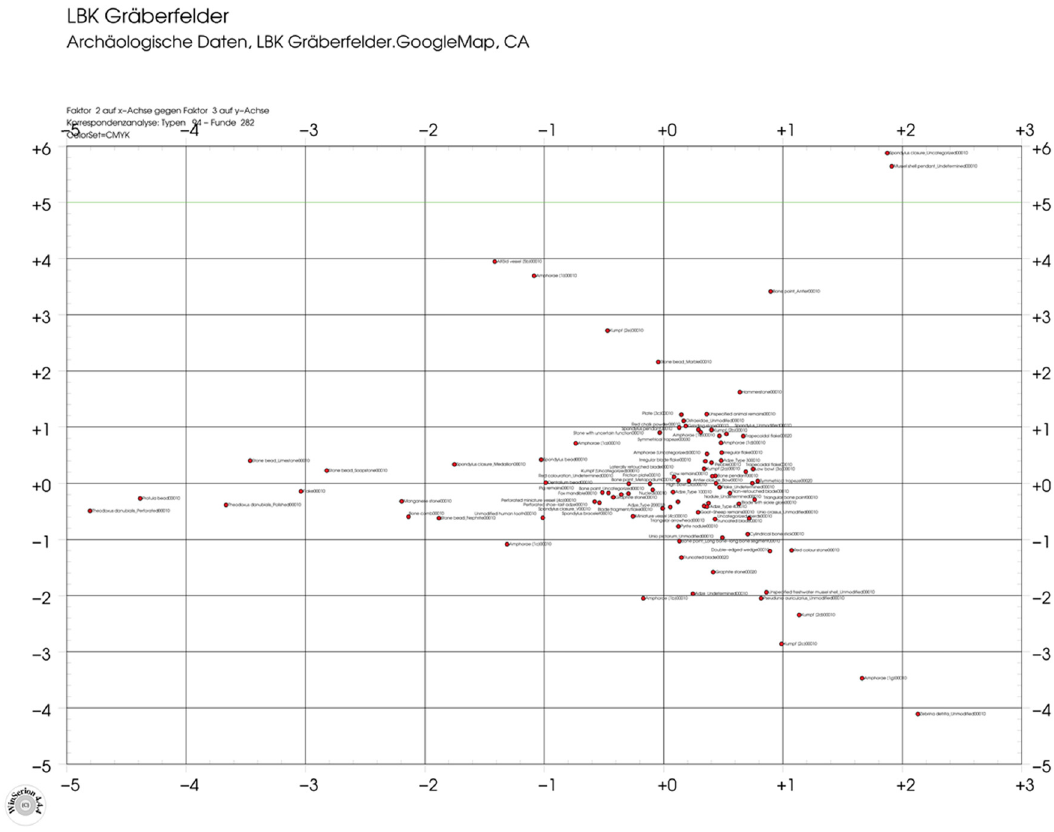
Figure 5: Correspondence analysis of the data set of grave goods for the regions selected in the master´s thesis ( Hahnekamp, 2020, p. 448, Figure App. 142 )